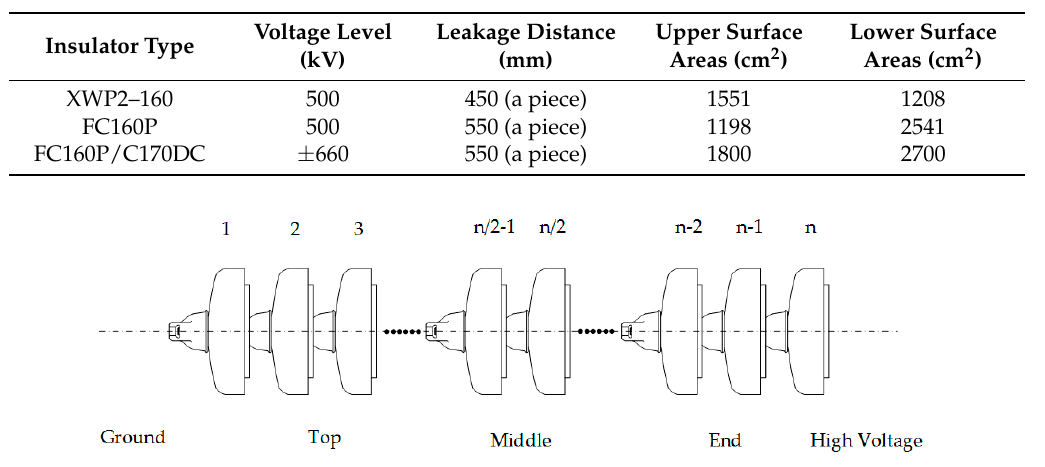
Figure 1. Insulator sampling diagram of suspension insulators.